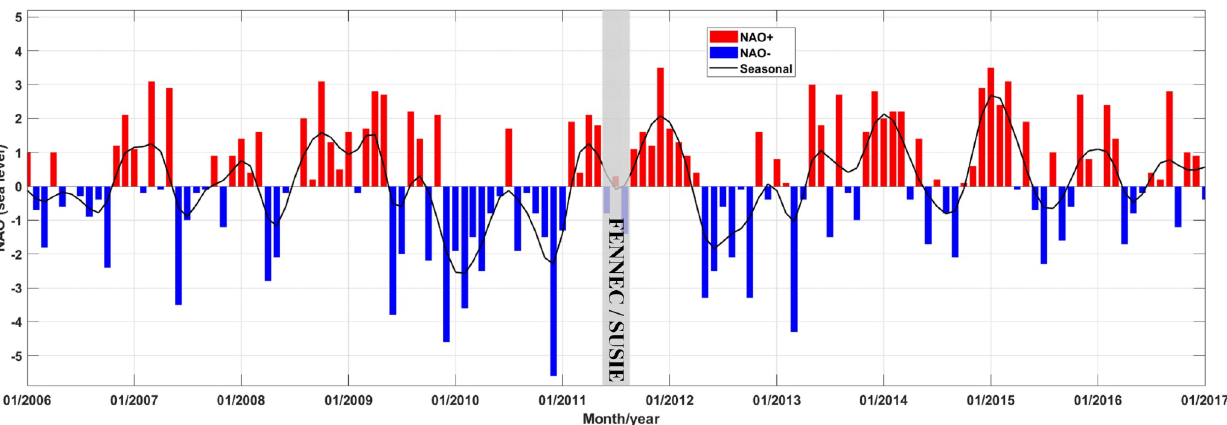
Figure 9. Temporal evolution of the monthly average North Atlantic Oscillation (NAO) index. The data are those of the site https: //climatedataguide.ucar.edu/climate-data/hurrell-north-atlantic-oscillation-nao-index-station-based. The grey area highlights summer 2011 when the SUSIE field campaign took place.